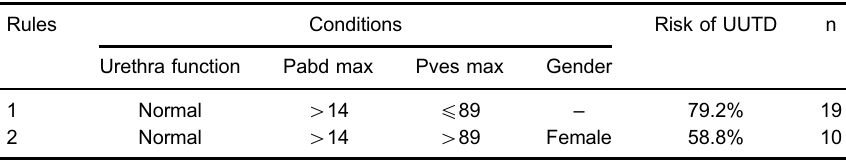
Figure 1. Decision tree model for risk of upper urinary tract damage (UUTD) in patients with neurogenic bladder. Pabd max: maximum abdominal pressure ( 4 14 cmH 2 O); Pves max (maximum intravesical pressure, p 89 cmH 2 O), Table 2. Classi fi cation rules of the decision tree model for risk of upper urinary tract damage